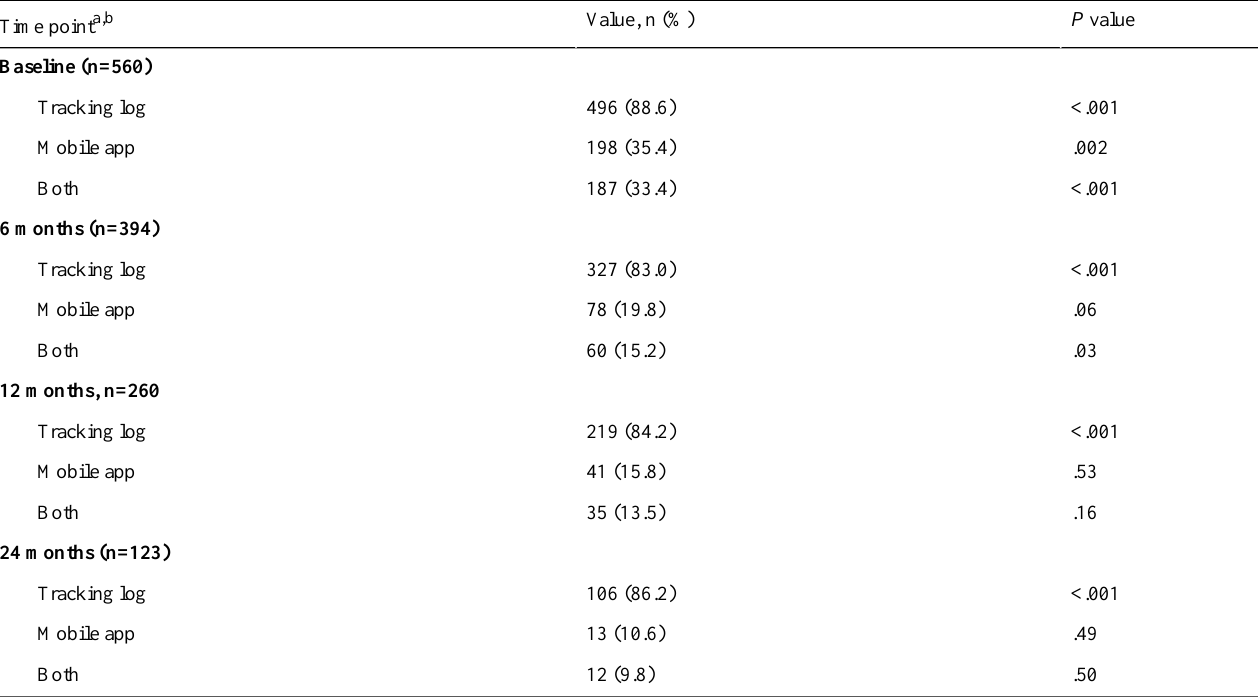
Table 4. Prevalence of tracking log completion and manufacturer mobile app engagement with compliant accelerometry data collection among the active Lifestyle Intervention for oVarian cancer Enhanced Survival participants who agreed to wear an accelerometer at each study time